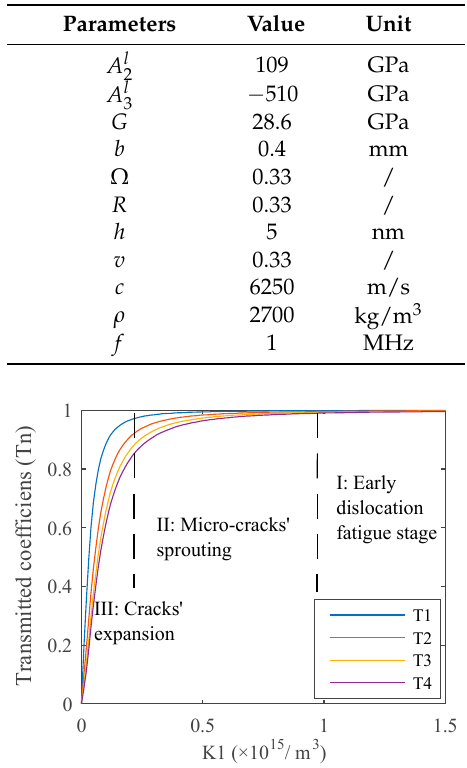
Table 1. Computational parameters of the aluminum alloy.